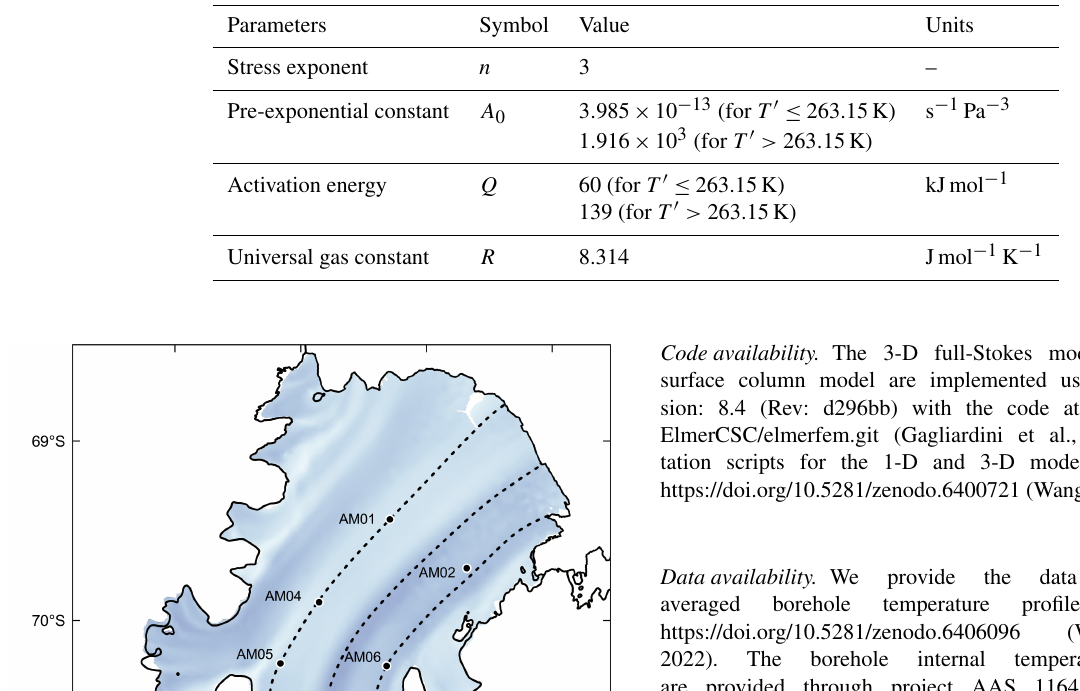
Table B1. Parameterised physical parameters for the Arrhenius law (Paterson, 1994).